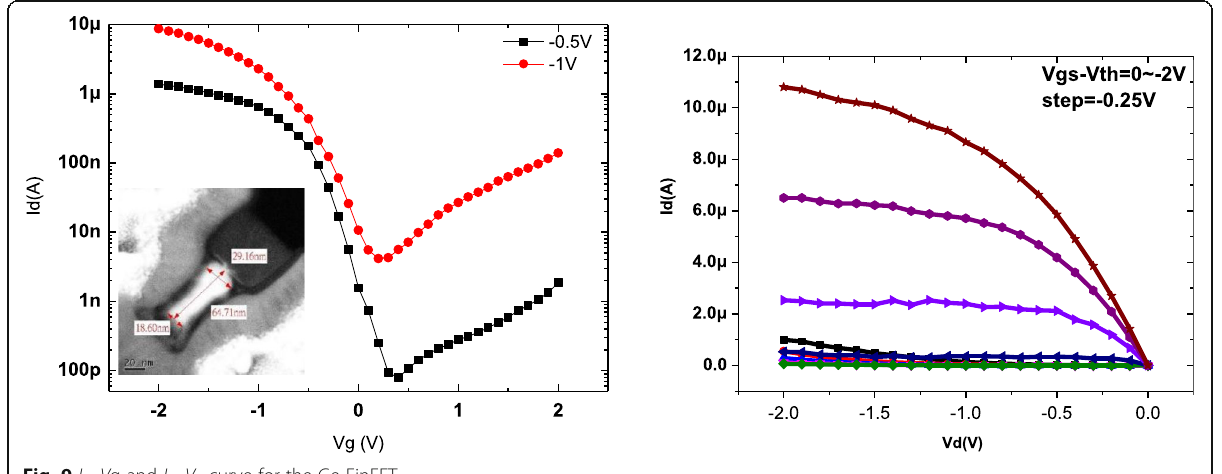
shown in Fig. 6 is approximately 1.8 V and close to the bandgap of Si ( E / q = 1.1 V) but not that of Ge ( E g